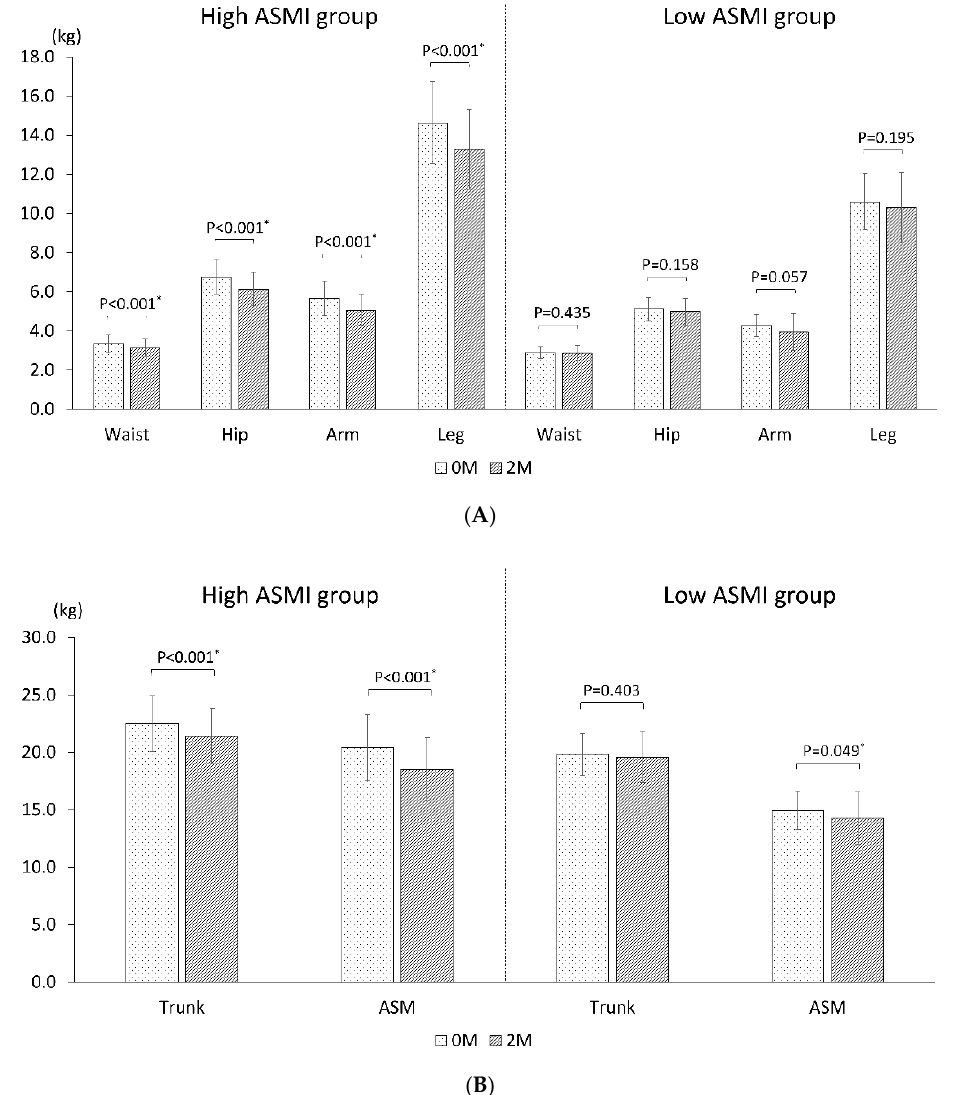
Figure 3. Comparison of lean mass changes during CCRT in patients with a high ASMI and in those with a low ASMI: ( A ) In different body regions; ( B ) In the central region (trunk) and peripheral extremities (ASM). In patients with a high ASMI, a significant loss of lean mass was observed consistently throughout different body regions. However, in patients with a low ASMI, there was no significant loss of lean mass in any region of the body; nevertheless, there was a significant loss of lean mass in the ASM mass. Significant p value were marked as *.